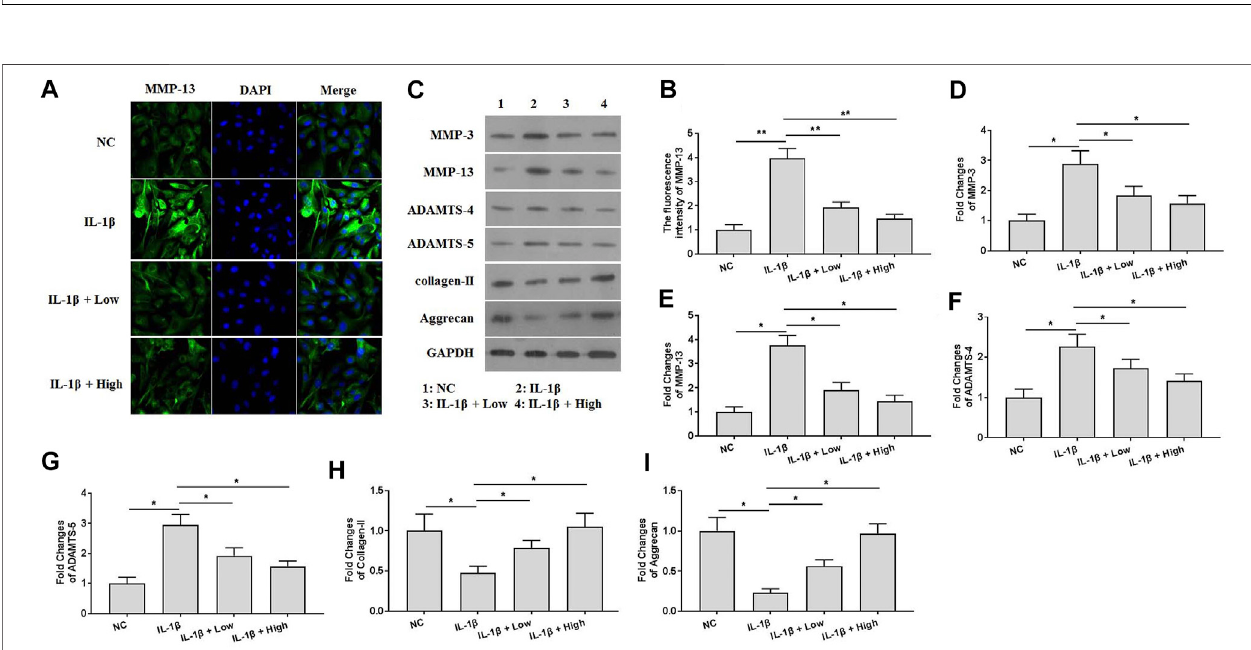
FIGURE4| XHattenuatedECMdegradationinIL-1 β -treatedchondrocytes. (A) Theimmuno fl uorescencestudyofMMP-13inIL-1 β -treatedchondrocytes. (B) The summarydataof fl uorescenceintensityofMMP-13. (C) TheproteinsexpressionofMMP-3,MMP-13,ADAMTS-4,ADAMTS-5,collagen-II,andaggrecanweredetected by western blotting. (D – I) were the quanti fi ed values of tested proteins. All experiments were performed in triplicate and data are presented as the mean ± standard deviation. * p < 0.05 and ** p < 0.01. NC, negative control; Low, XH (5 μ M); High, XH (20 μ M).